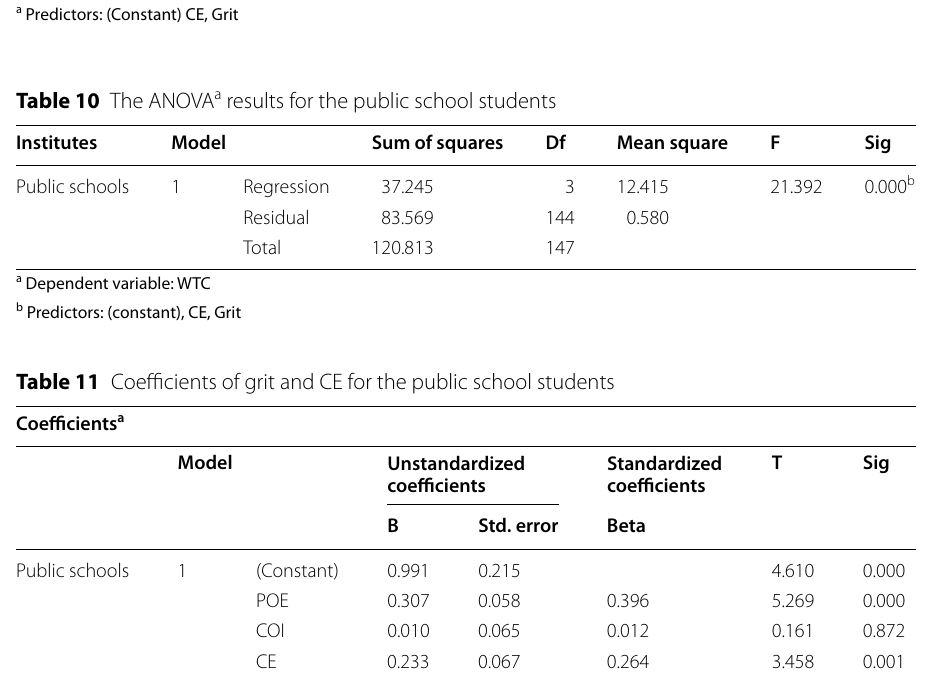
a Dependent variable: